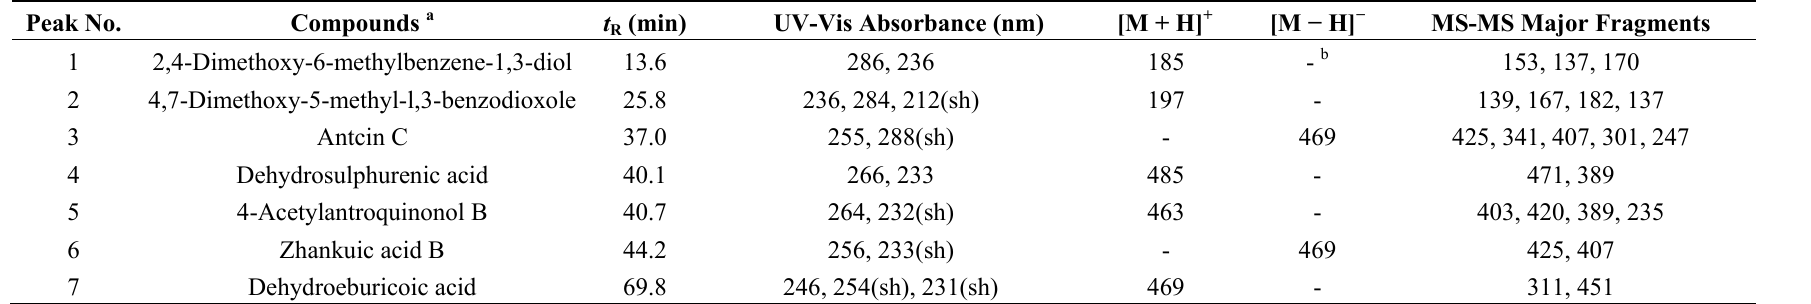
Table 2. Chemical characterization of the main compounds detected in the supercritical fluid and ethanolic extracts of solid-cultured mycelia of A. cinnamomea by liquid chromatography-tandem mass spectrometry (LC-MS/MS) analysis. Peak No.